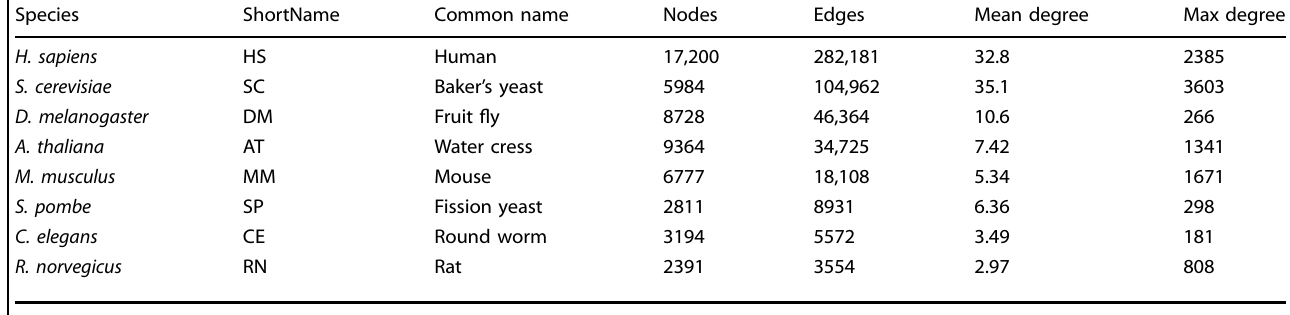
Table 1. TOP: BioGRID (version 3.4.164, downloaded Sept. 2018), sorted by number of edges.